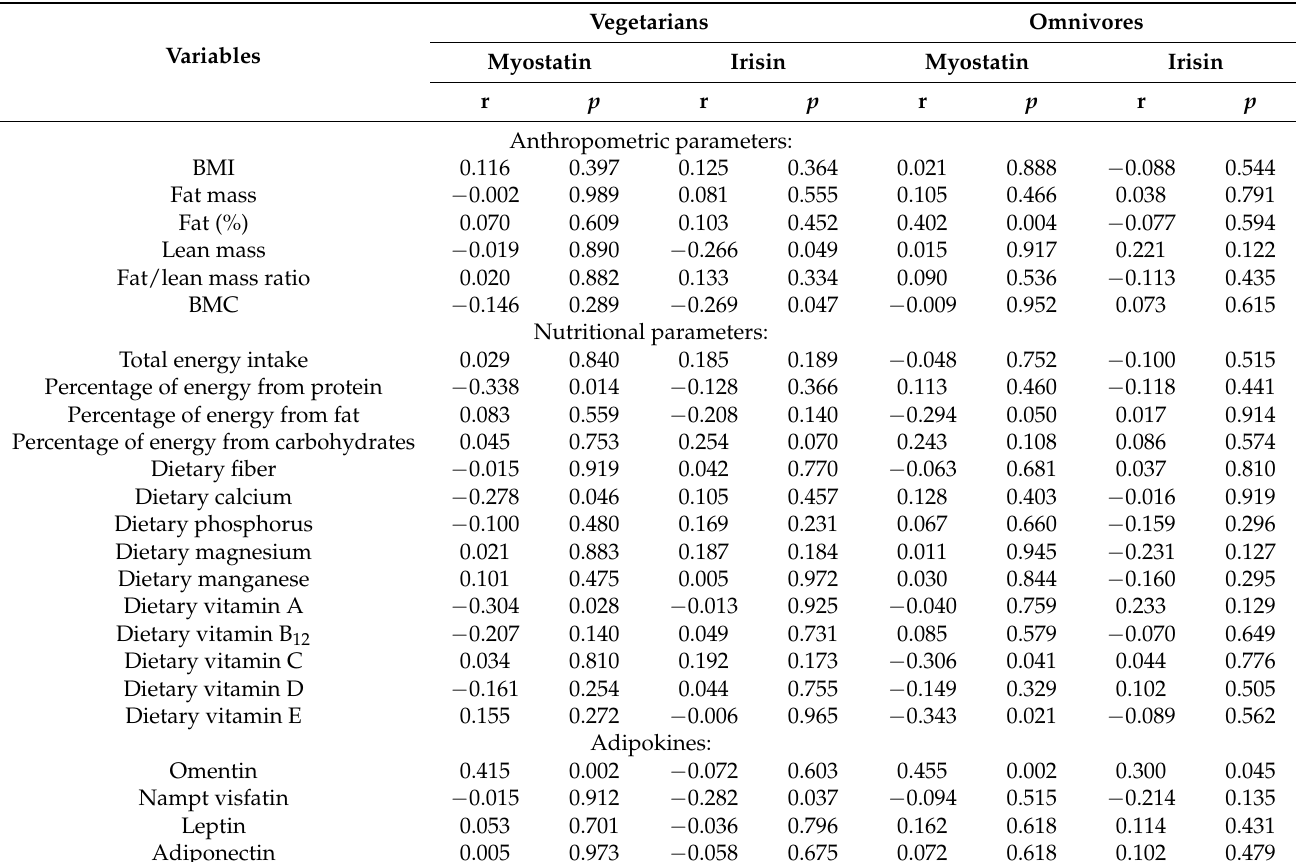
Table 4. Spearman’s correlations of myokine concentrations with anthropometric parameters, nutritional parameters, and adipokine levels in vegetarian and omnivorous